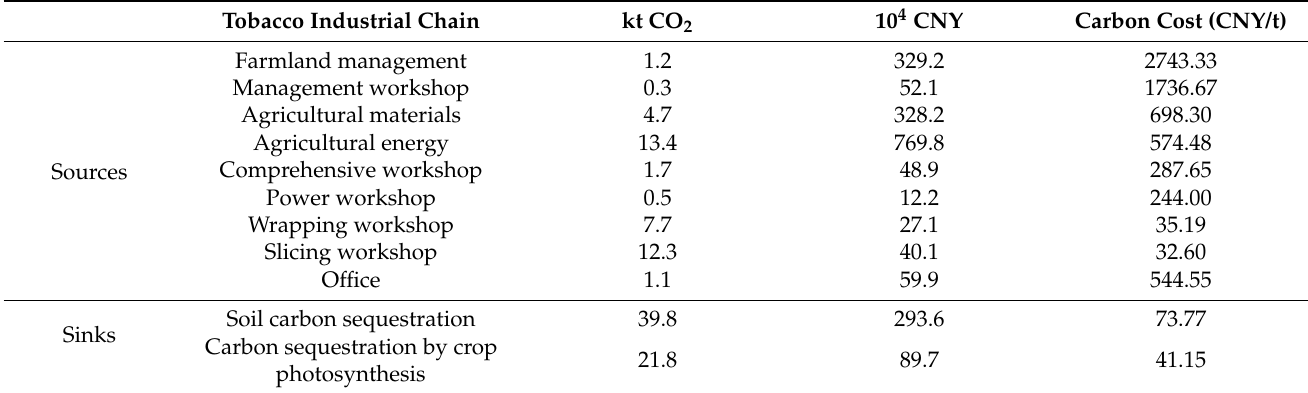
Table 3. Tobacco industrial chain with an input of 15% clean